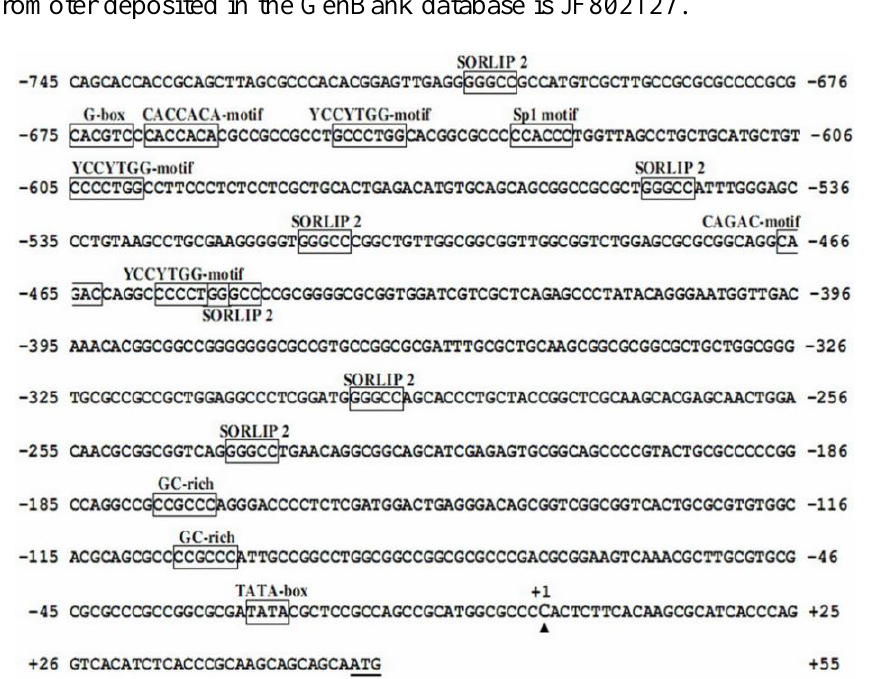
Figure 1. Nucleotide sequence of the AcRbcS promoter. The start codon (ATG) was underlined and the putative transcriptional start site (TSS) was indicated by a vertical arrow and referred to as position +1. The putative TATA-box and other cis -acting elements were boxed and the names are given above the elements. The accession number of the AcRbcS promoter deposited in the GenBank database is